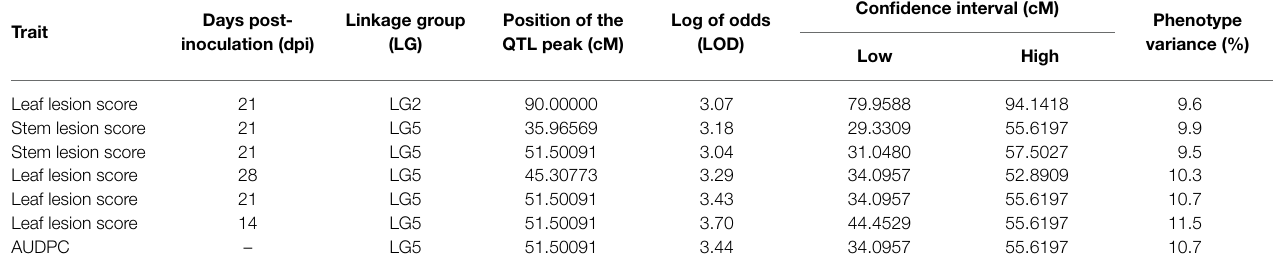
TABLE 3 | Quantitative trait loci for AB resistance determined in the ILWL 180 × ILL 6002 RIL population. Days post- Trait inoculation (dpi)